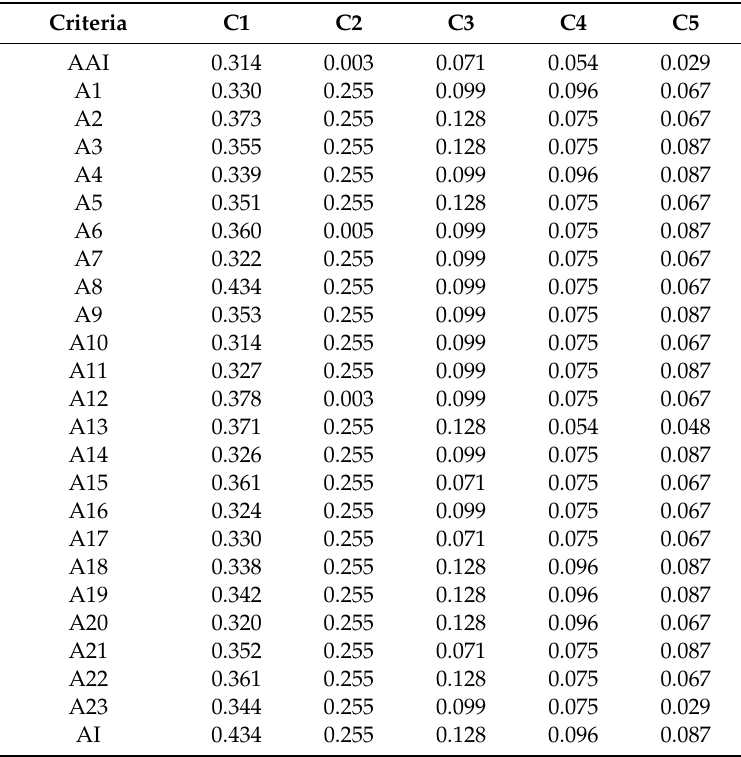
Table 4. Weighted normalized decision